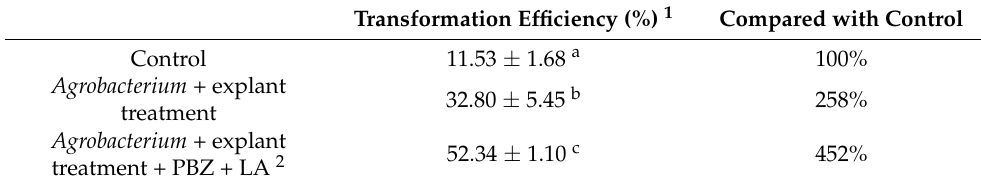
Table 1. Transformation Efficiencies of ‘Carrizo’ Citrange with Treatments